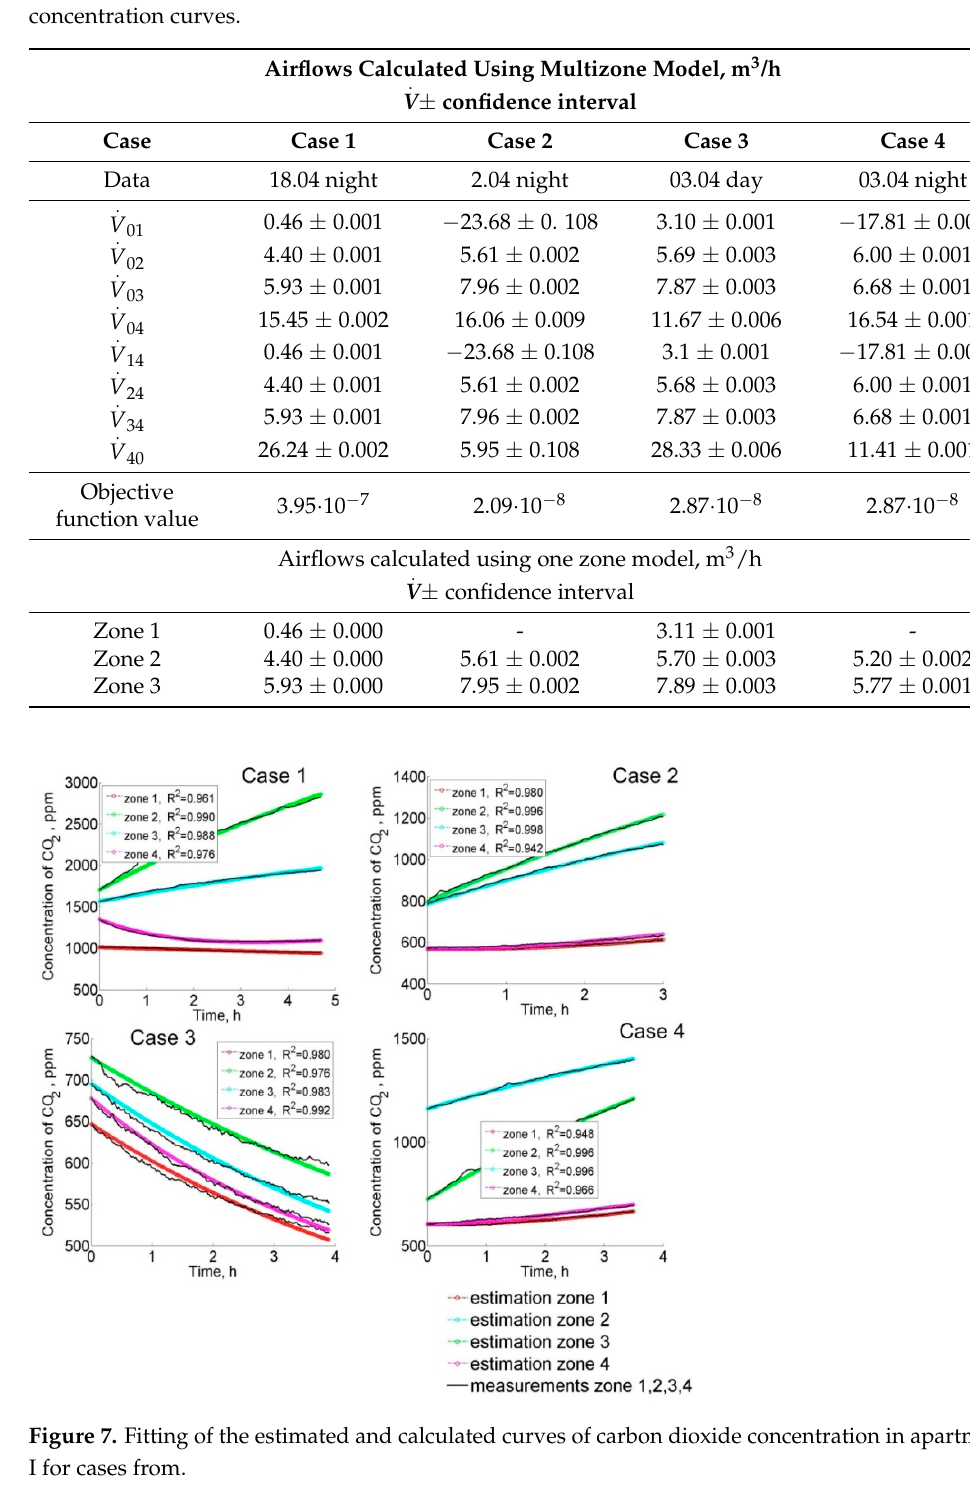
Table 4. Results of the estimated airflows in apartment I for selected monotonic fragments of CO 2 concentration curves.